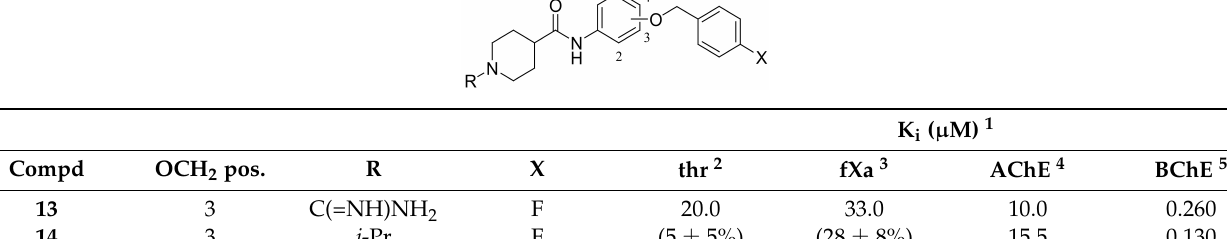
Table 2. Inhibition of N 1-substituted isonipecotanilide derivatives on blood coagulation factors (thr, fXa) and cholinesterases (AChE, BChE).